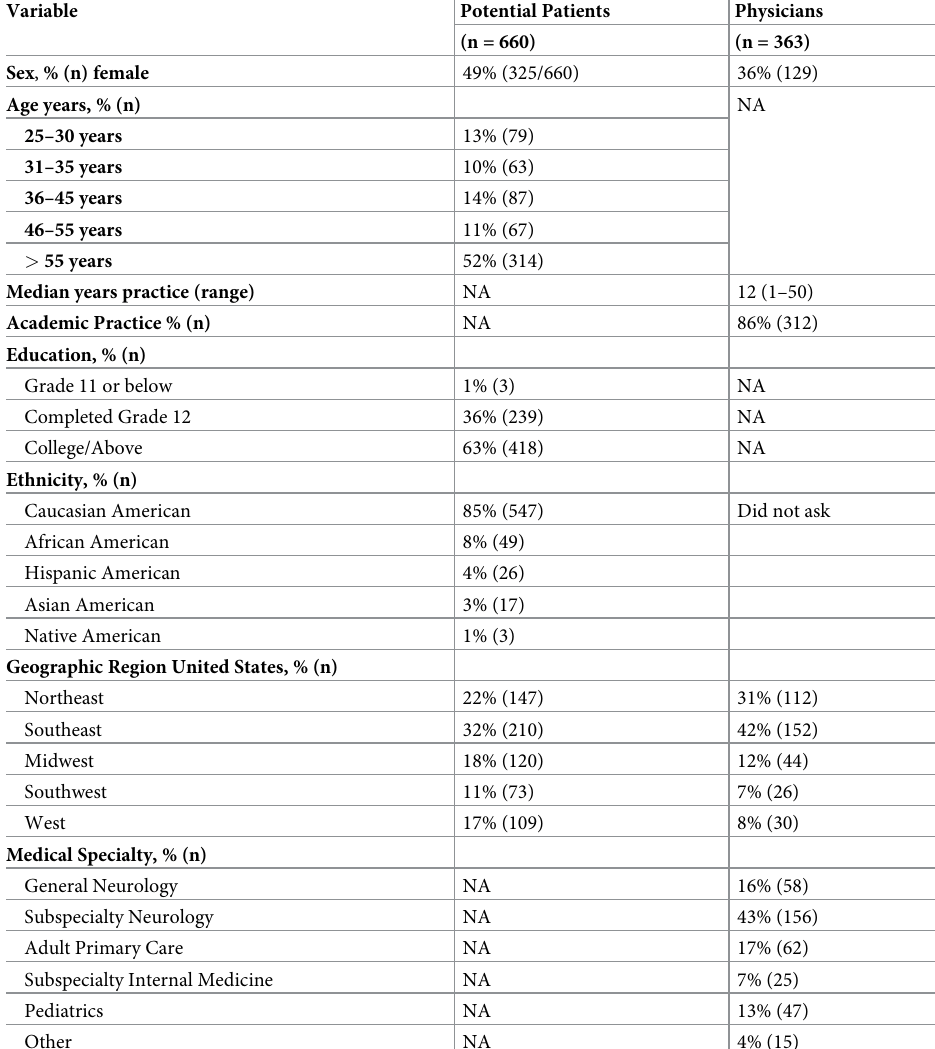
Table 2. Baseline